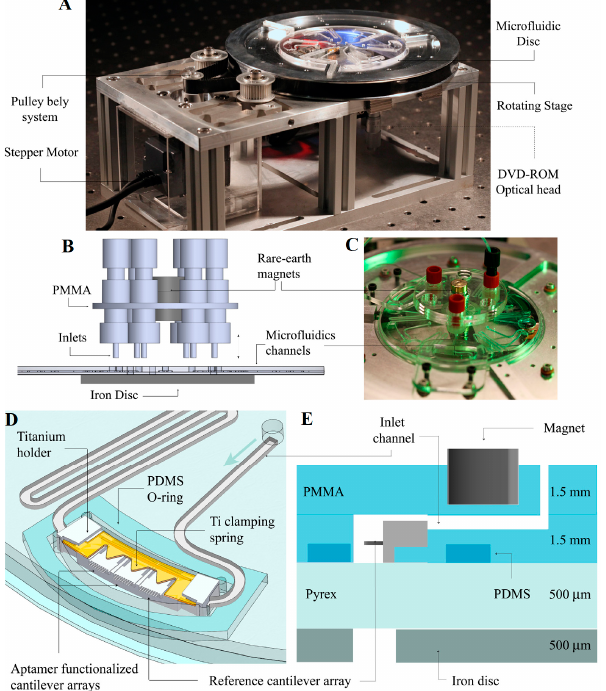
Figure 13. ( A ) Picture of the complete setup; ( B ) schematic view of magnet-based microfluidic inlet assembly; ( C ) a polymer disc connected to nozzles through rare earth magnets; ( D ) installation schematic of the chip on the titanium alloy bracket; ( E ) installation schematic of polymer chip composed of PDMS and PMMA [156].